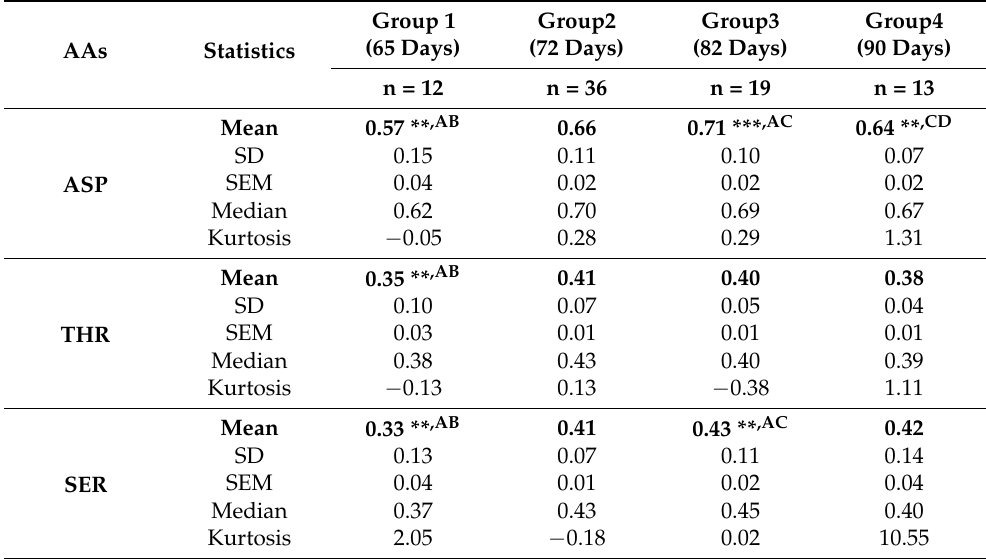
Table 1. The total amount of amino acids (AAs) in pig blood serum in each of the four groups (n = 80) depending on the fattening duration (65–90